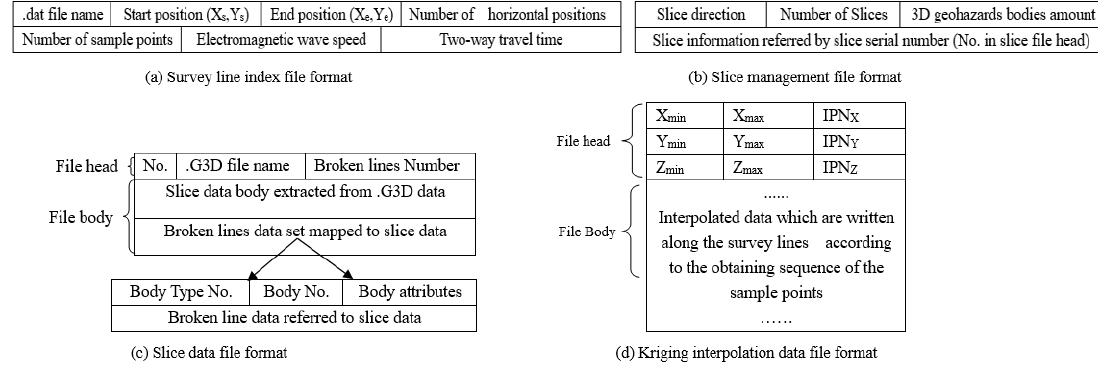
Figure 4. The file formats in 3DVF4UDR.